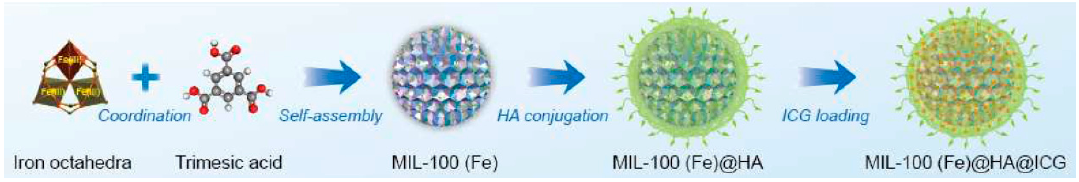
Figure 9. Schematic representation of the synthesis procedure, HA conjugation and ICG loading of MIL-100(Fe) NPs [97].